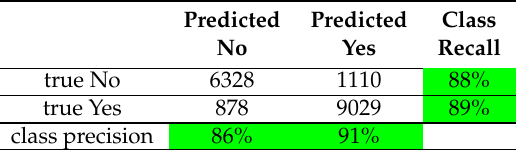
Table 6. Confusion matrix for DNN for High class.